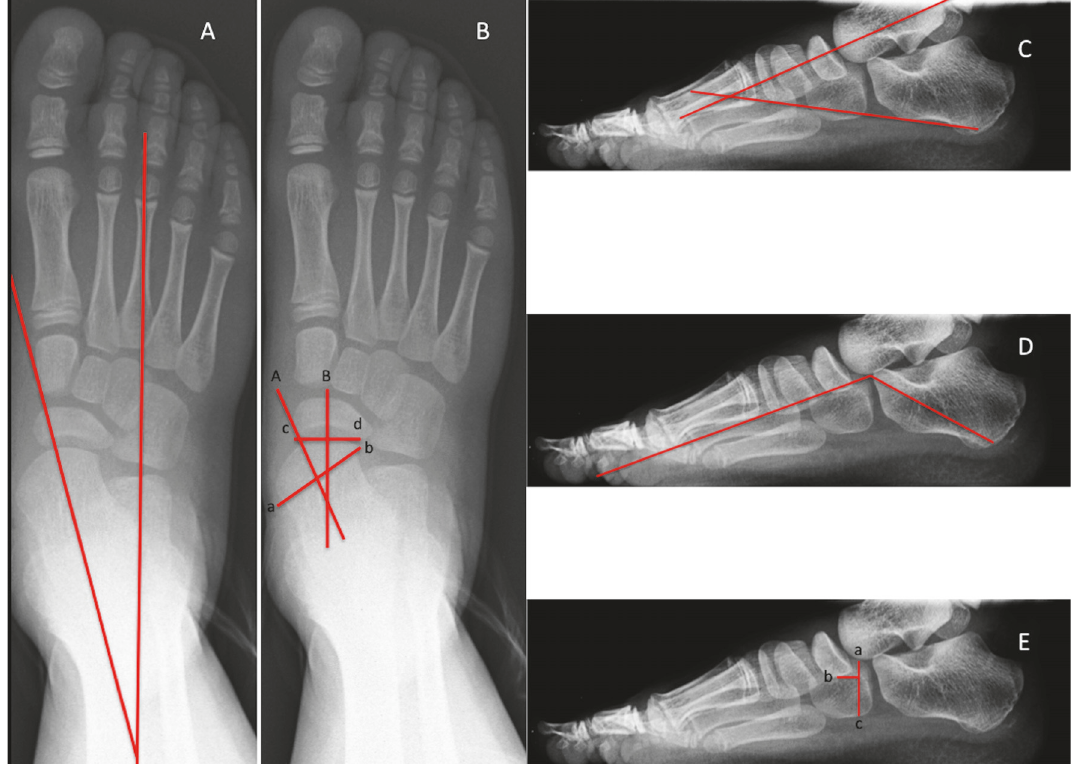
Figure 1: The graphical representation of angles measures used in the study. A: DP talocalcaneal angle. B: talonavicular coverageangle. Points a and b = medial and lateral edges (resp.) of the articular surface of the talus bone. Points c and d = medial and lateral edges (resp.) of the articular surface of the navicular bone. Line A is perpendicular to ab, and line B is perpendicular to cd. Talonavicular coverage is the angle created by the intersection of lines A and B. C: talocalcaneal angle in lateral radiography. D: Moreau-Costa-Bartani angle. E: naviculocuboid overlap. Points a and b = superior and inferior margins (resp.) of the cuboids. Point c = inferior margin of the navicular. Naviculocuboid overlap = ac/ab X